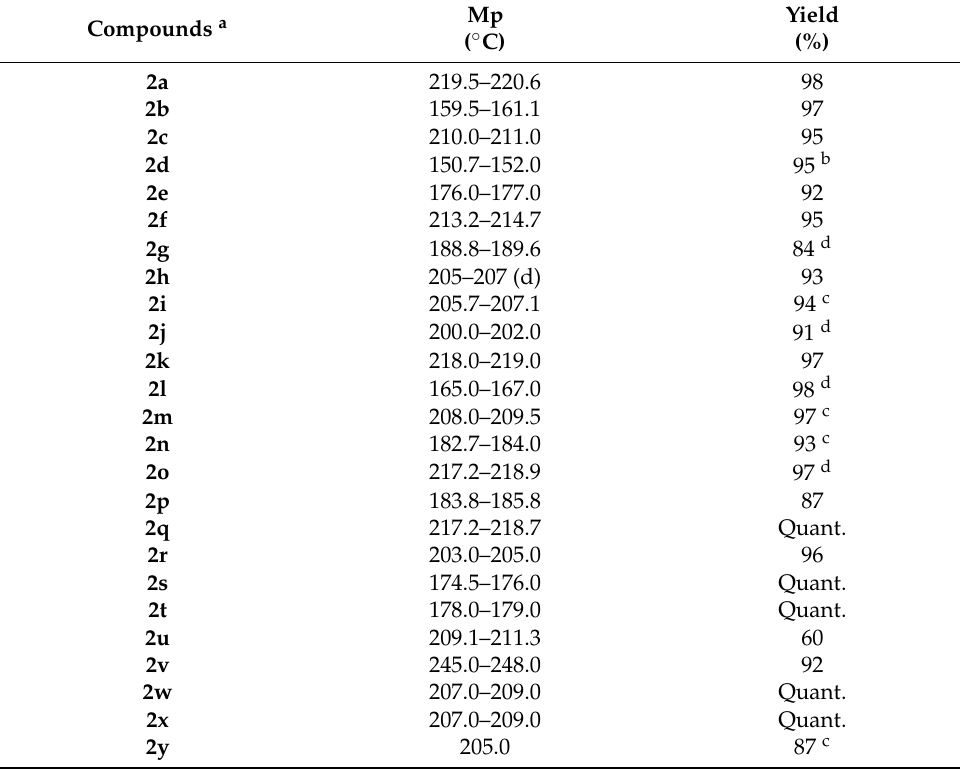
Table 1. Synthesis of 4,4 (cid:48) -(arylmethylene)bis(3-methyl-1-phenyl-1 H -pyrazol-5-ols) derivatives 2a – y catalyzed by 10% NaOAc at room